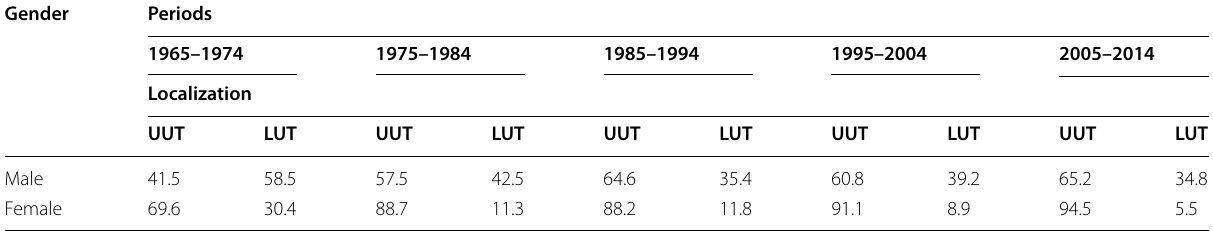
UUT: Upper Urinary Tract, LUT: Lower Urinary Tract